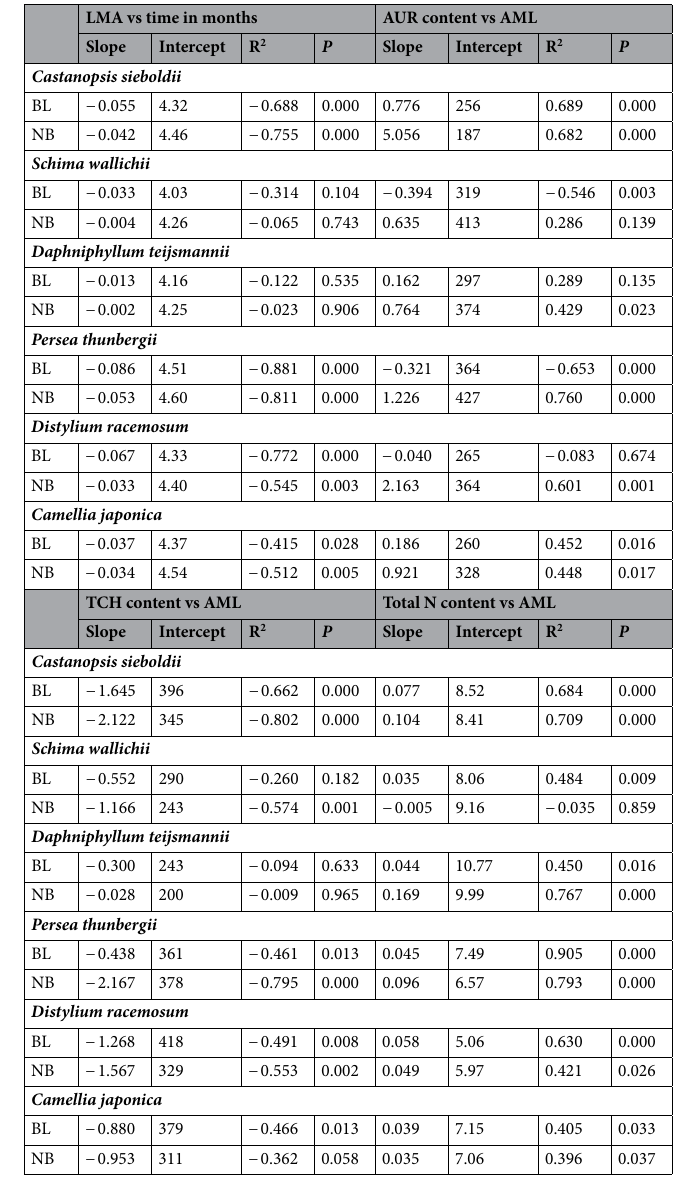
Table 1. Slopes and intercepts of regression equations for linear relationships between leaf mass per area (LMA; % initial value, ln-transformed) and decomposition time in months and between contents of chemical components and accumulated mass loss (AML) in bleached (BL) and nonbleached (NB) portions of leaf